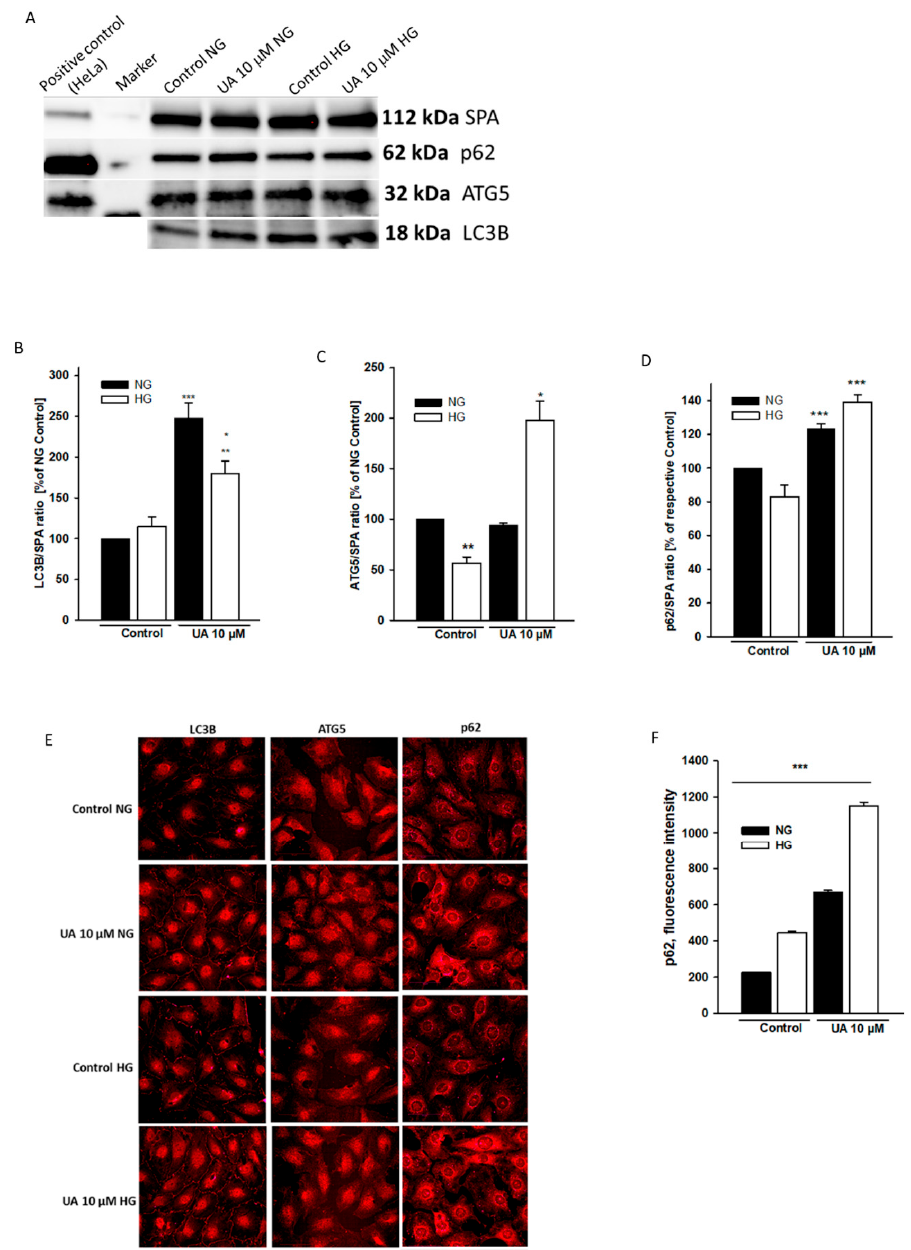
Figure 9. Expression of autophagic markers was upregulated by UA. Podocytes cultured for 7 d in normal (5.5 mM, NG) or high (25 mM, HG) glucose were incubated for 24 h with 10 µM UA. Immunofluorescence and Western blot analysis were performed to examine the expression patterns of autophagic markers LC3B, ATG-5, and p62. A representative immunoblot ( A ). Quantitative densitometric analysis was used to determine the ratios of LC3B ( B ), ATG-5 ( C ), and p62 ( D ) to Alpha 1 Sodium Potassium ATPase (SPA). Results of experiments performed in duplicate show mean ± SEM ( n = 3 for ATG5 and p62, n = 4 for LC3B). The Student’s t -test was used to calculate p values. For LC3B ( B ) * p < 0.05 vs. HG Control, ** p < 0.01 vs. NG Control, *** p < 0.001 vs. NG Control. For ATG-5 ( C ) * p < 0.01 vs. NG-UA and vs. NG Control, ** p < 0.001 vs. NG Control and vs. HG-UA. For p62 ( D ) *** p < 0.001 vs. respective Control. Representative confocal microscopy images of immunofluorescent staining against LC3B, ATG-5, and p62 ( E ). Quantification of p62 expression ( F ). 500 cells were analyzed per experiment ( n = 3), *** p < 0.001 NG vs. HG and UA vs.